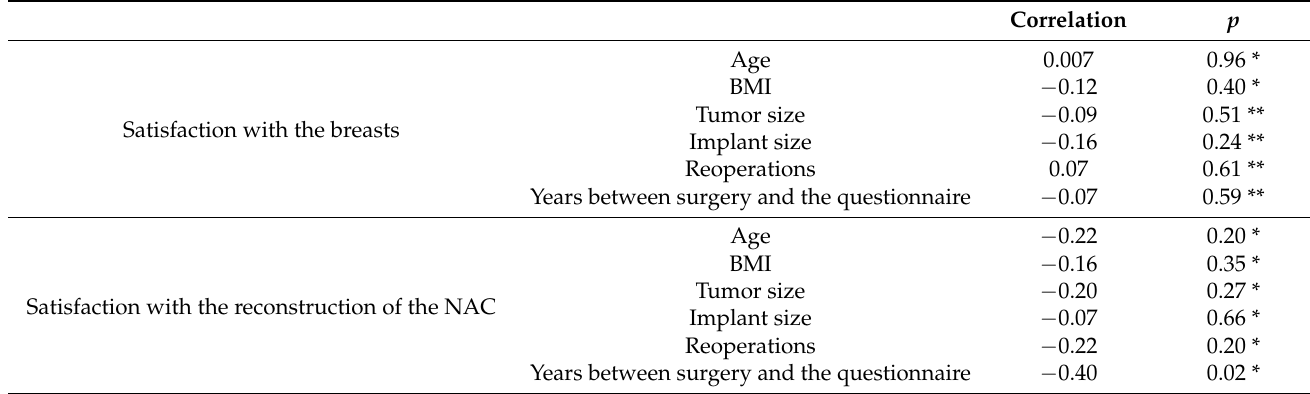
Table 8. Correlation between the score on the satisfaction with results scales and patient’s characteristics.